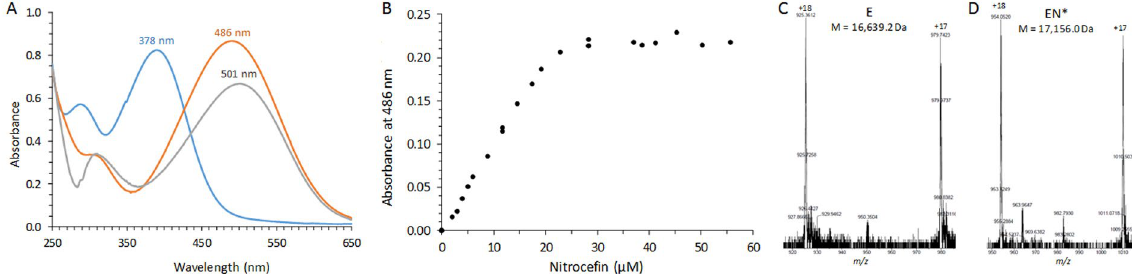
Figure 2. Determination by spectrophotometry of the acylation of Ldt fm by nitrocefin. ( A ) Absorbance spectra of various forms of nitrocefin (50 µ M). Blue, native nitrocefin; orange, nitrocefin hydrolyzed by BlaC; grey, nitrocefin in the acyl-enzyme formed with Ldt fm . ( B) Titration of the active site of Ldt fm (22 µ M) by nitrocefin. ( C and D ) Mass spectra of Ldt fm and of the acyl-enzyme formed with nitrocefin. The average mass of Ldt fm (E) and of the acyl-enzyme (EN * ) were deduced from the m / z ratios of the [M + 17 H] 17 + and [M + 18 H] 18 + ions. The calculated mass of nitrocefin, Ldt fm , and of the acyl-enzyme were 516.5 Da, 16,639.3 Da, and 17,155.8 Da,